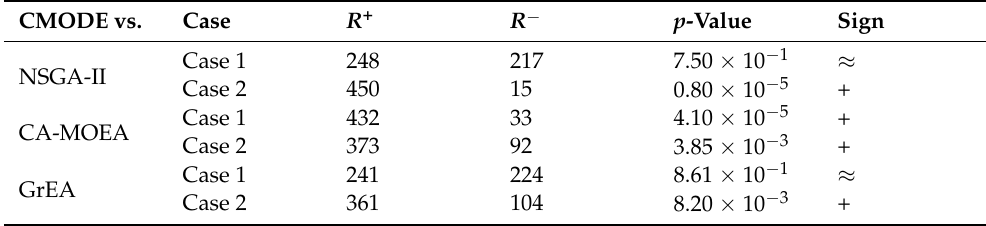
Table 5. R − , p -value for the HV values of CMODE and other rivalries. CMODE